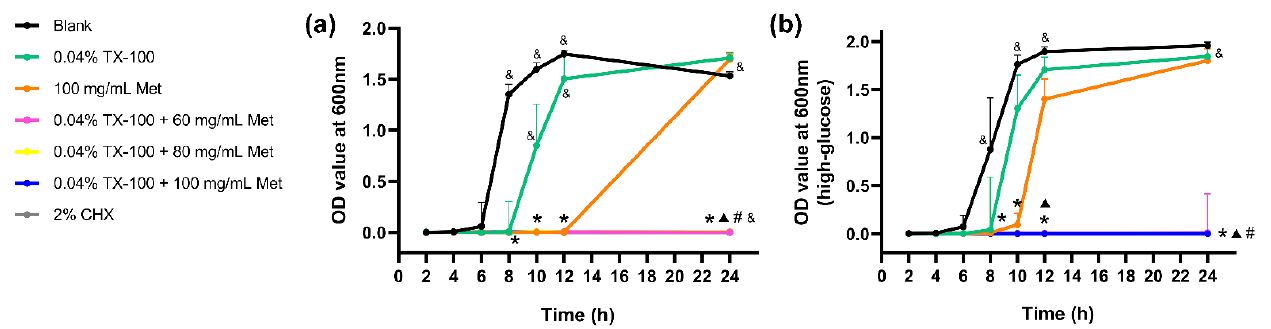
Figure 2. Growth curves of E. faecalis on dentin slices. ( a ) in normal BHI; ( b ) in high-glucose BHI. (*: significant difference compared with the blank control group; ▲ : significant difference compared with the 0.04% TX-100 group; #: significant difference compared with the 100 mg/mL Met group; &: significant difference compared with the 2% CHX group; p < 0.05).